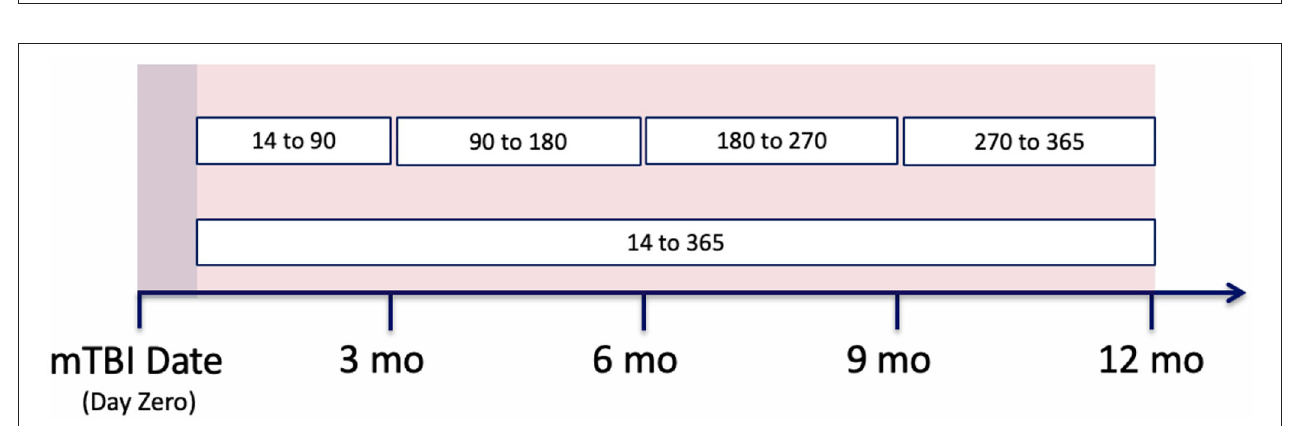
FIGURE 4 | Different model types and their performance using window configuration C on predicting 14–365 days. (A) ROC Curves. (B) Precision-Recall Curves.